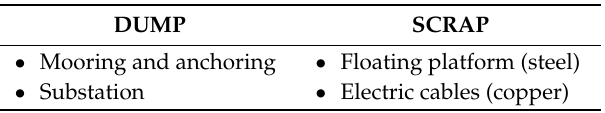
Table 3. Use of the general components once they were